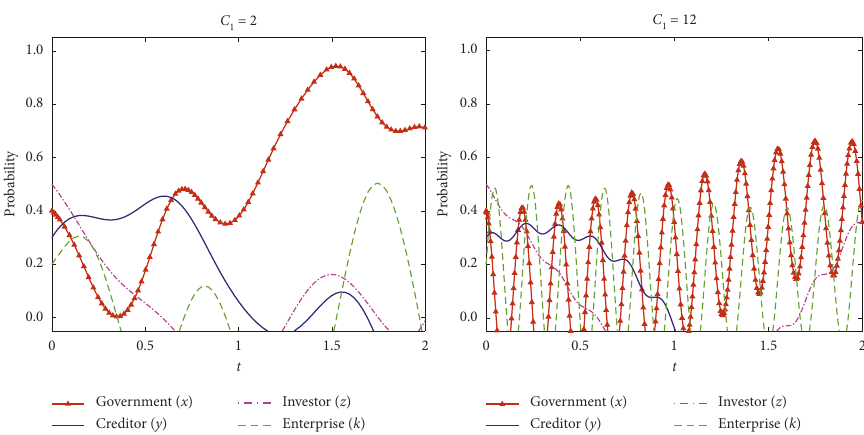
Figure 5: The impact of government support costs on system